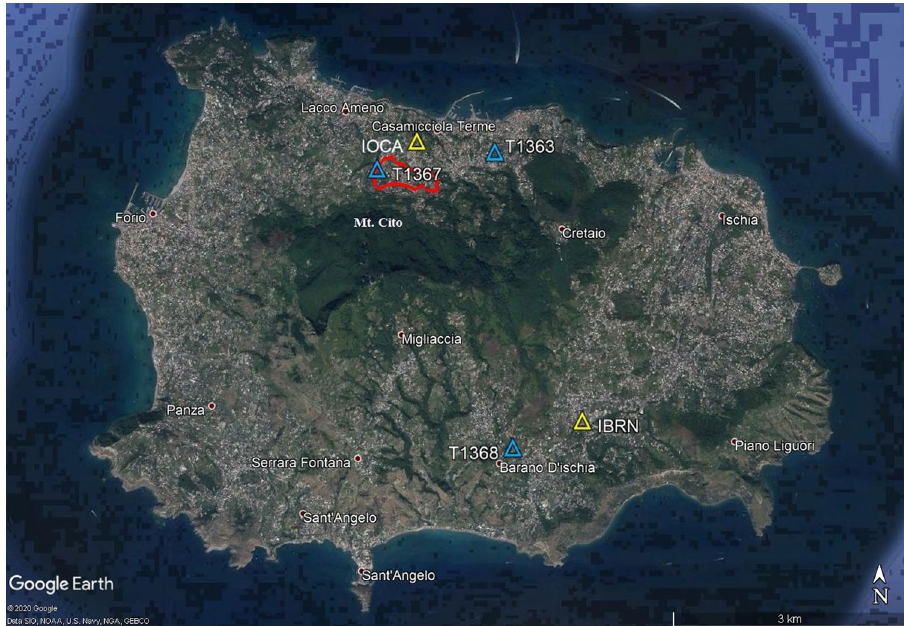
Figure 1. Map of Ischia Island with the stations reported as triangles (Map data 2018 Google retrieved from https:// www. google. it/ maps/@ 40. 72516 46,13. 90327 32,8719m/ data= !3m1!1e3). Permanent stations 22 are indicated in yellow and temporary ones 23 in light blue. The red line surrounds the forbidden area (red zone) most struck by the M D 4 earthquake of August 21,